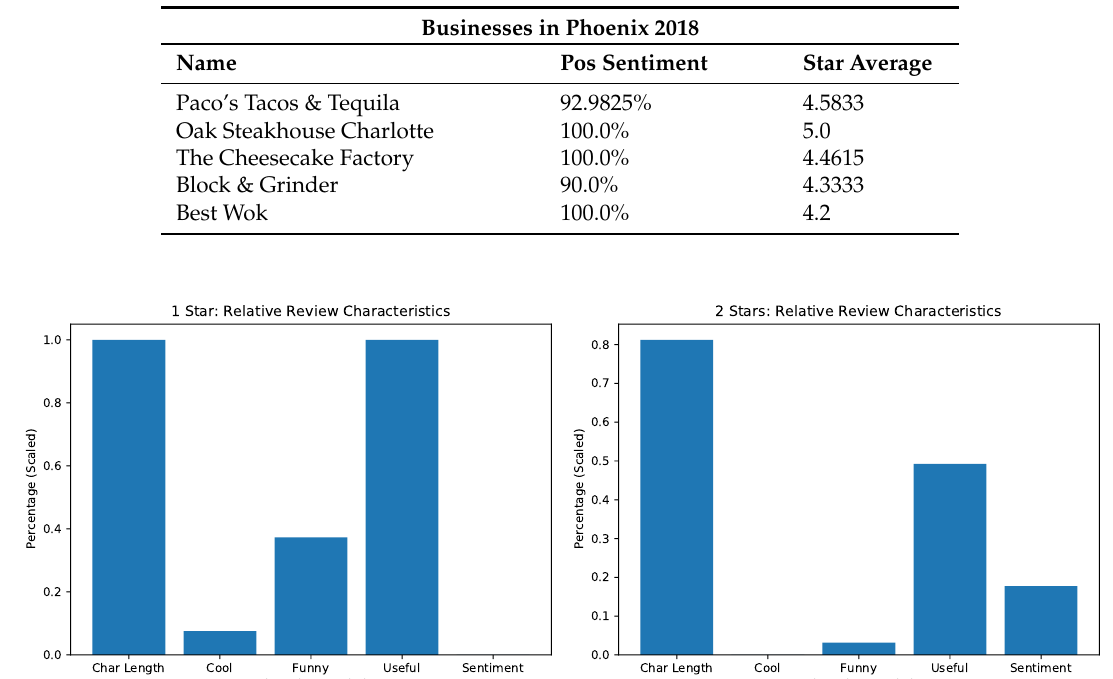
Table A1. The result of the analysis “Kate’s Restaurant Recommendation”. Only results with 5 reviews or more are displayed.